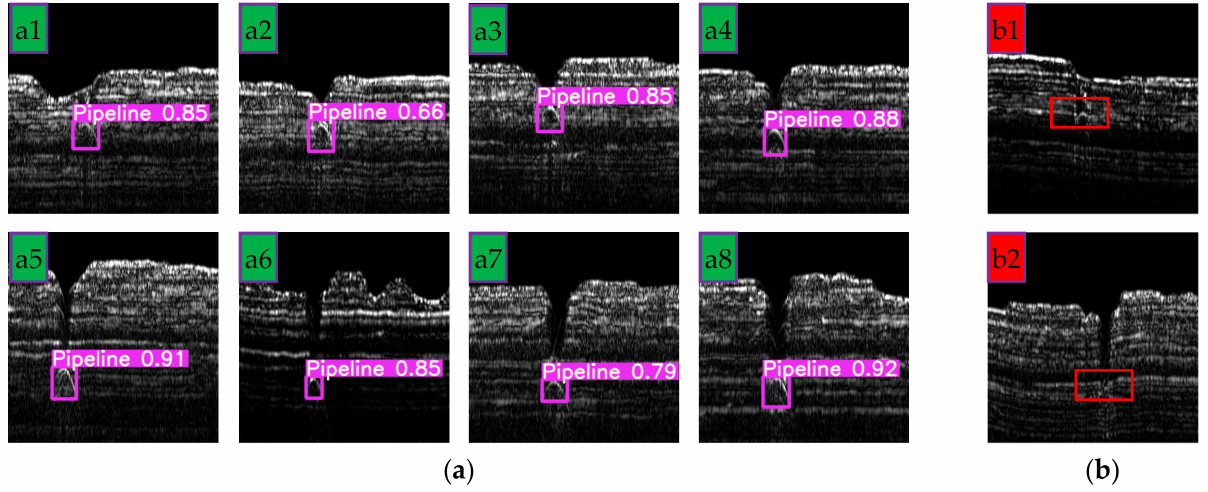
Figure 24. Part of the correct detection results of the proposed method. ( a ) Part of the correct detection results; ( b ) missed detection